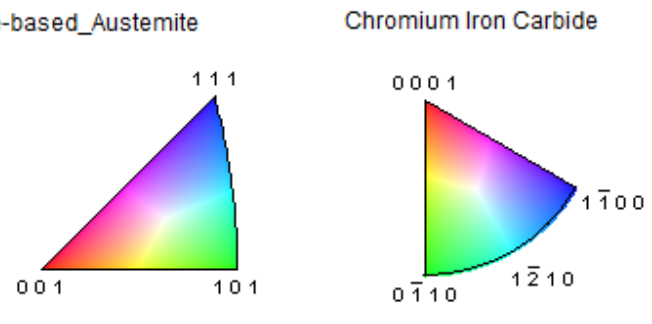
Figure 8. Structure of chromium cast iron in a 40 mm thick plate. ( a ) light microscope; ( b ) EBSD.